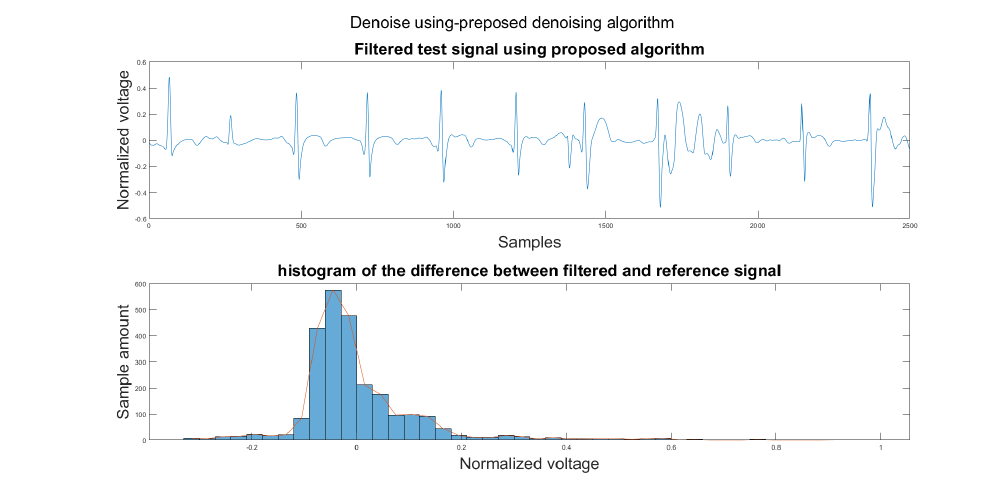
Figure A22. (1) Test signal, (2) histogram of the difference.